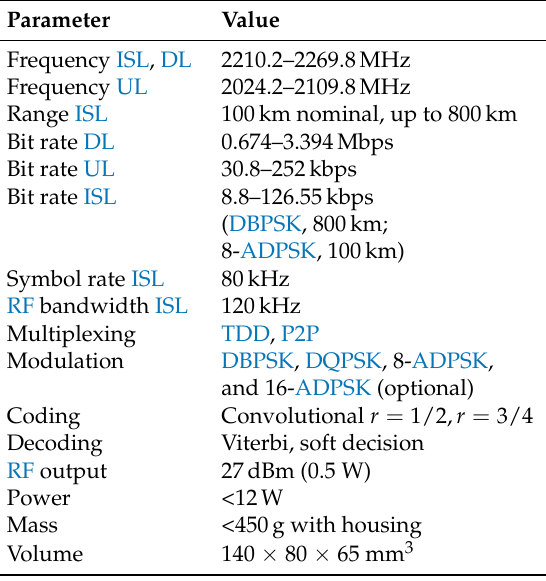
Figure 11. View of Sband radio SLINK for ISL, UL, DL, and antenna switch. Table 9. Parameters of the SLINK